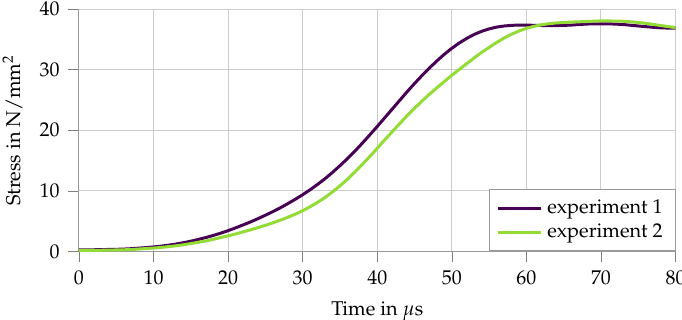
Figure 6. The characteristic trapezoidal loading pulse of the modified split Hopkinson tension bar, as measured in the in input bar, from [5,27]. Here, only the rise is depicted as the first crack occurs before the plateau is